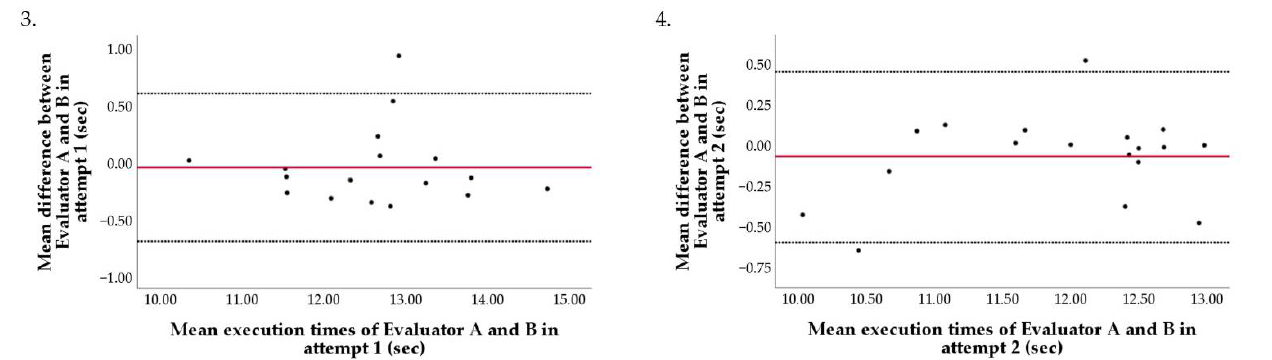
Figure 2. Bland–Altman plots of the measured execution times between Evaluator A and B, and between Attempts 1 and 2. Comparisons are illustrated by differences between pairs of measurements as a function of the mean measurements. Panel 1 shows the comparison between Attempts 1 and 2 for Evaluator A, and Panel 2 for Evaluator B. Panel 3 shows the comparison between Evaluator A and Evaluator B for Attempt 1 and Panel 4 for Attempt 2. Red line represents the mean difference between the corresponding compared measurements. The dotted black lines demonstrate the upper and lower bound of the 95% confidence intervals.